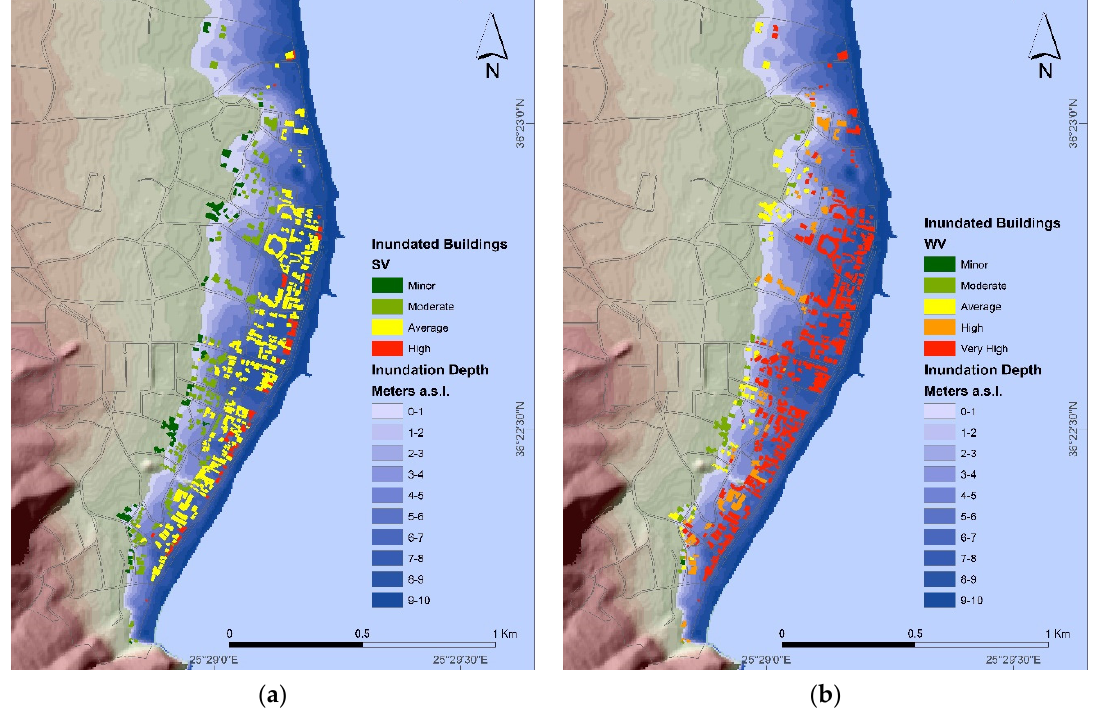
Figure 8. Maps depicting the spatial distribution of: ( a ) Structural Vulnerability (SV) and ( b ) Water Vulnerability (WV) factors.